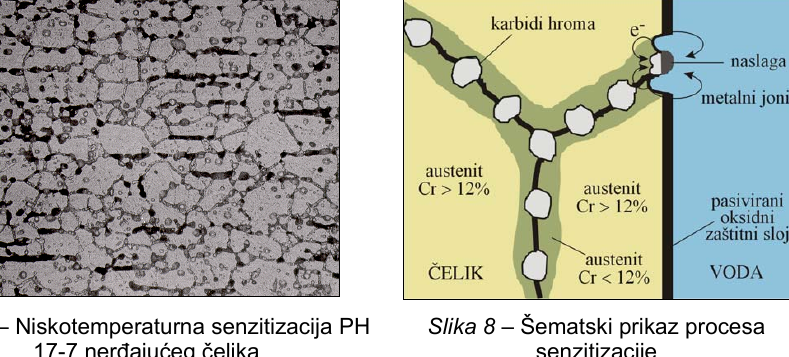
Рис . 7 – Сенсибилизация РН 17-7 нержавеющей стали при низкой температуре Figure 7 – Low temperature sensitization on PH 17-7 stainless steel